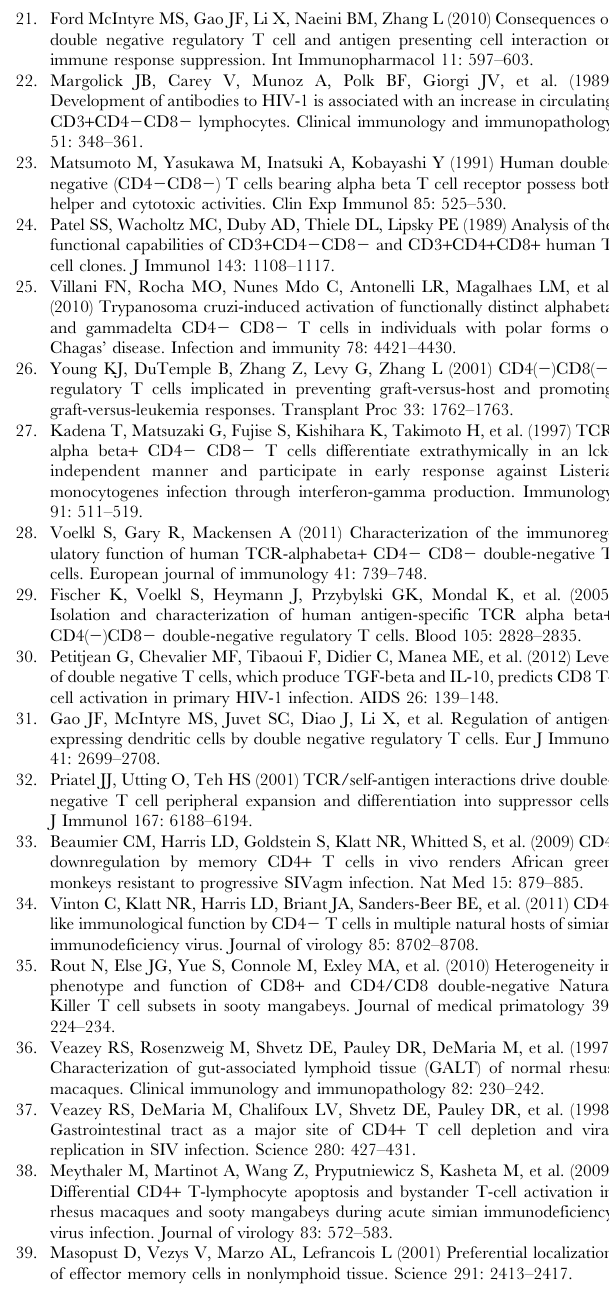
Table S1 Primer sequences of 25 V b regions amplified. Primer sequences were based on Rhesus specific TCR. Primer included in each set and final primer concentrations are indicated. Table S2 Junctional diversity of the V b amplified during spectratyping. Table includes number of peaks, peak range and tallest peak are listed for each V b amplified